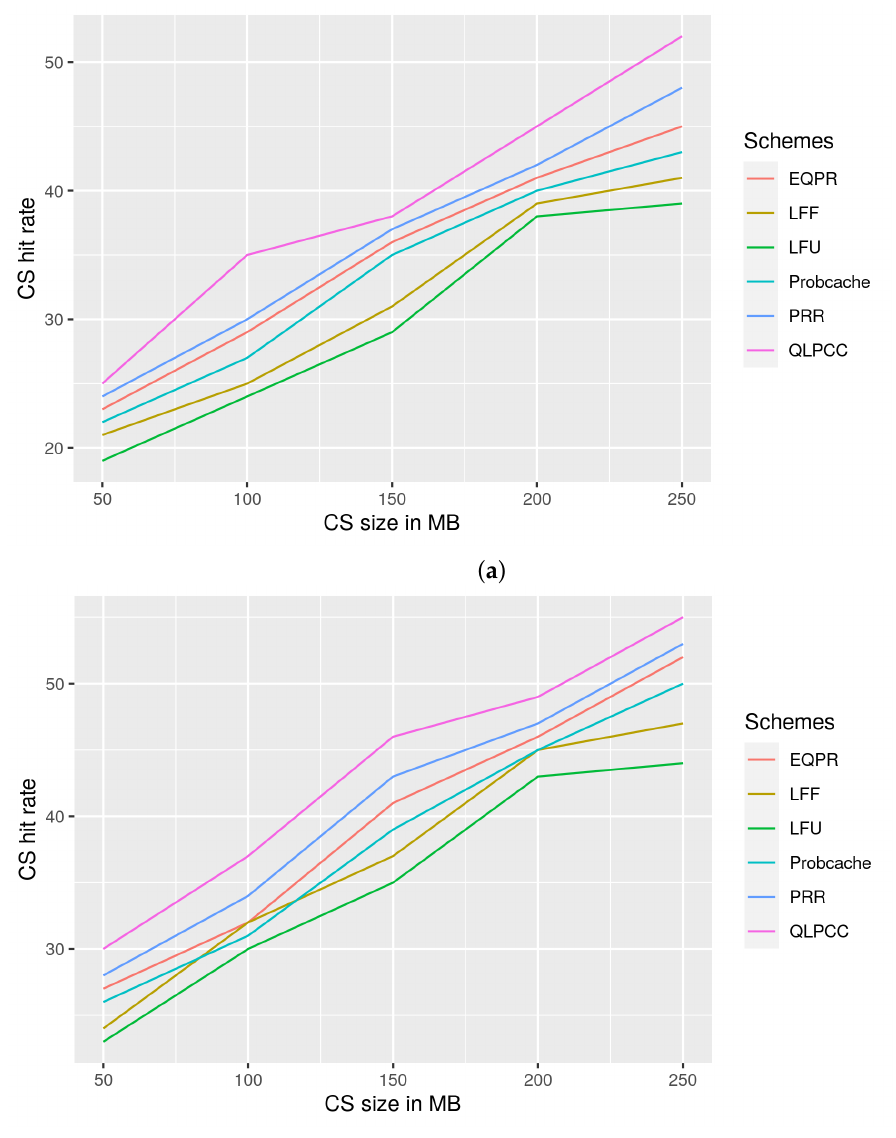
Figure 6. Content store size vs. hit rate for overall traffic. ( a ) Content store size vs. hit rate (overall traffic) for | M | = 500. ( b ) Content store size vs. hit rate (overall traffic) for | M | =